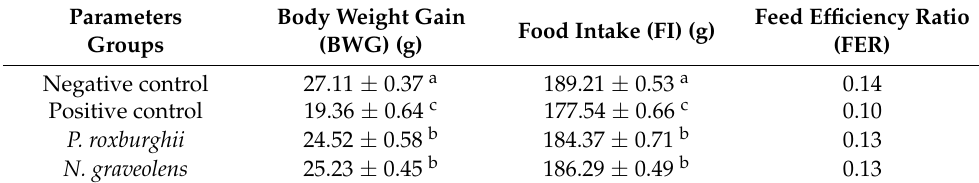
Table 2. Nutritional parameters of different